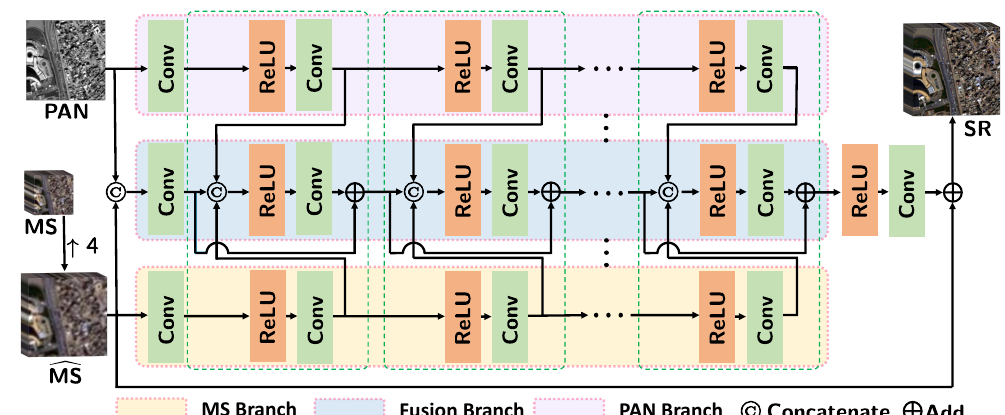
Figure 2. The overall architecture of the proposed full-depth feature Fusion Network (FDFNet). Please note that the kernel size of the convolution in FDFNet is 3 × 3, the channels of the PAN branch and MS branch is 16, and the channels of fusion branch is 32. For more details, please refer to Section